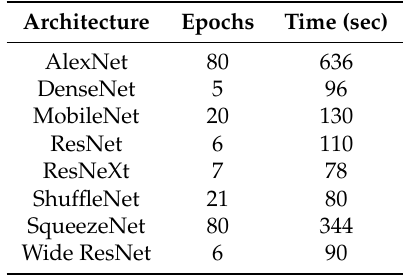
Table 6. Training epochs and time for the TB5 free-space